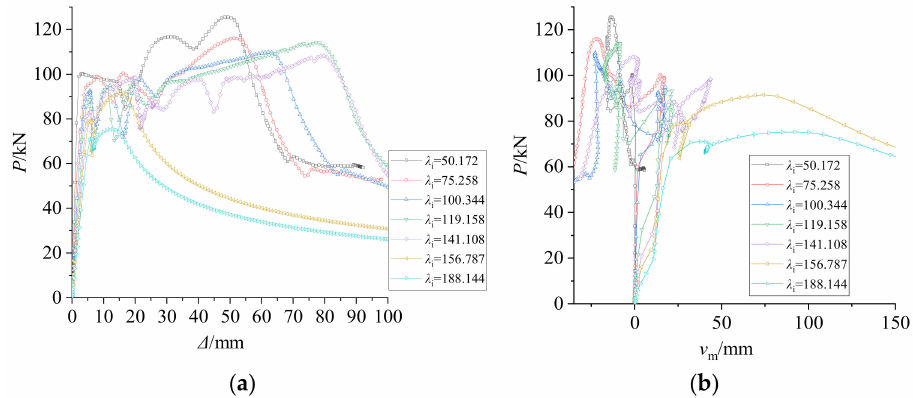
Figure 16. Effect of core slenderness ratio: ( a ) P - ∆ relationships; ( b ) P - v m